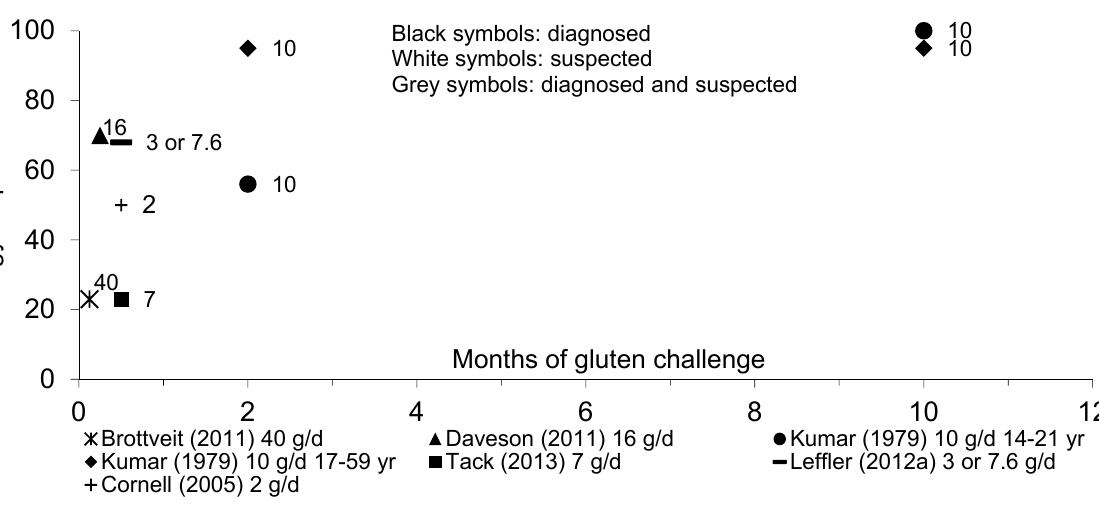
Figure 6. Percentage of adult patients with diagnosed or suspected CD showing histological response to gluten over